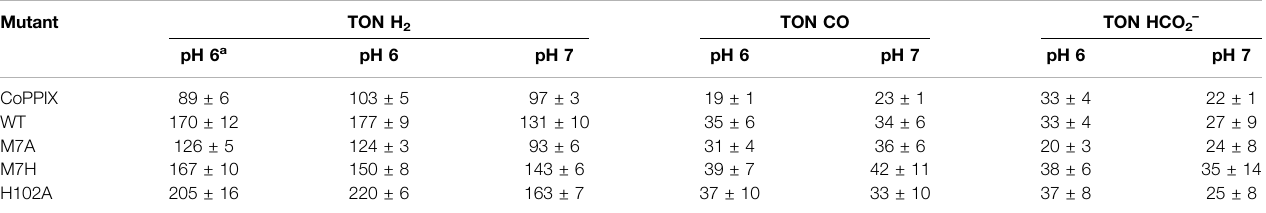
TABLE 2 | Turnover numbers for the observed products under light irradiation in 200 mM potassium phosphate, 100 mM ascorbic acid, 1 mM [Ru(bpy) 3 ] 2+ , and 1 atm of gas. Mutant